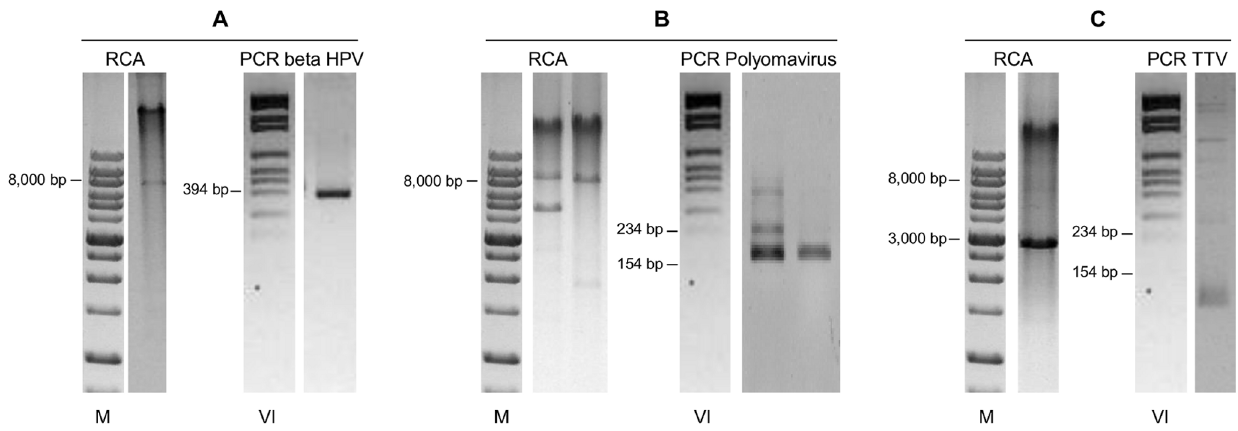
Figure 5. RCA analysis and specific PCR analysis of Linear Array-negative, RCA positive samples. A. RCA product digestion with Bam HI showed a band of about 8,000 bp; the sample was positive for cutaneous HPV following amplification with CP primers; B. RCA product digestion with Bam HI showed several restriction fragments # 8,000 bp; these samples were negative for cutaneous HPV (not shown) but positive for Polyomavirus; C. RCA product digestion with Bam HI showed a band of about 3,000 bp; the sample was negative for cutaneous HPV and for Polyomavirus, but positive for TTV. Proper negative and positive controls were used for each virus-specific PCR (not shown). M , molecular marker DM013-R500 (Gene-DireX, USA). VI , molecular marker VI